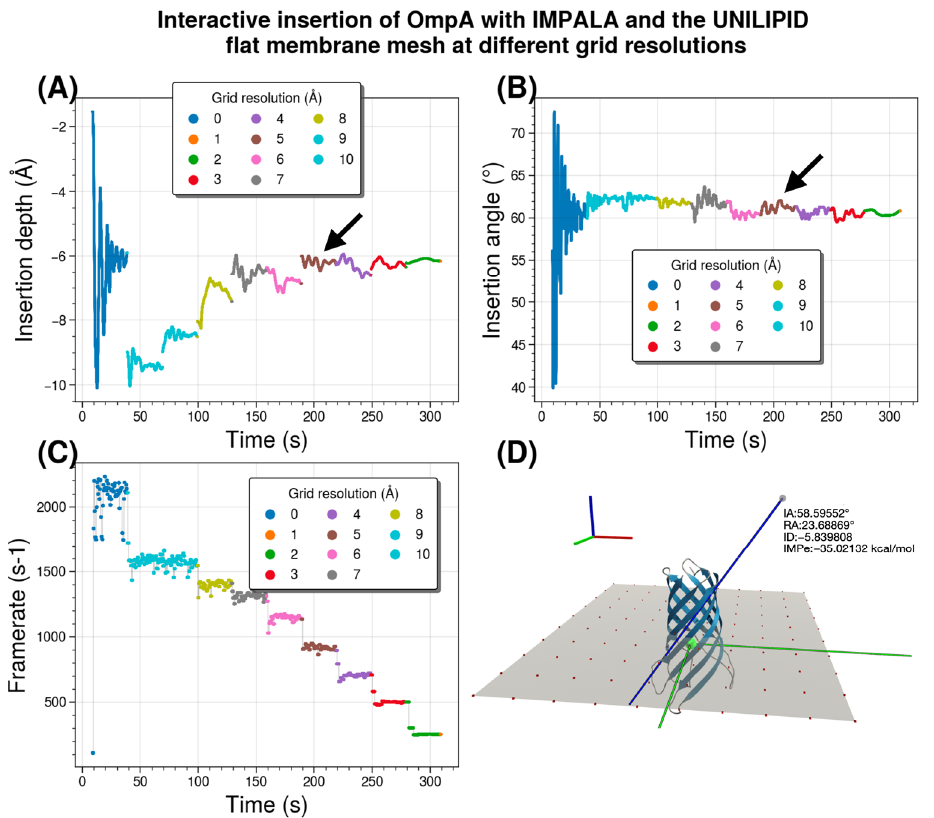
Figure 9. Comparison of an analytical membrane representation, given in the legend as “REF”, with a mesh representation with varying lattice spacing and decreasing lattice roughness through a sequence from 10 Å to 1 Å by 1 Å steps. Results are for the OmpA membrane protein. The time axis on the abscissa of figure panels ( A – C ) is the actual measured time. ( A ) Measured insertion depth for the series of experiments. A black arrow indicates a result close to the reference value. ( B ) Measurements of the insertion angle. A black arrow indicates values approaching the reference angle. ( C ) Simulation update rate for all experiments. ( D ) Graphical representation of a planar mesh with 10 Å resolution and an inserted protein.